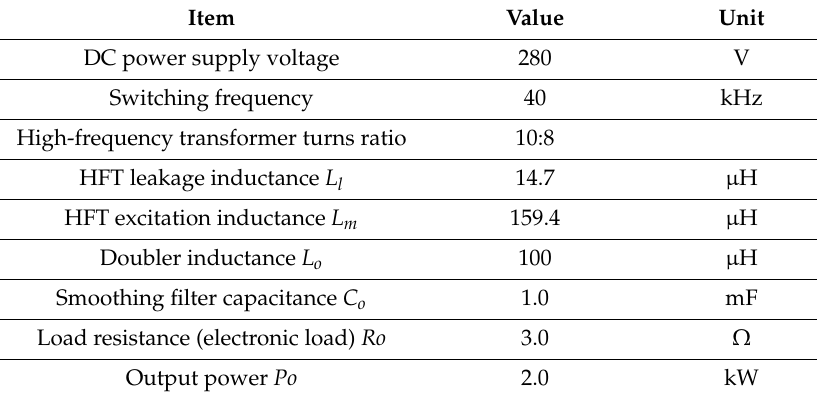
Figure 9. The exterior appearance of laboratory setup of the studied DC–DC power converter.